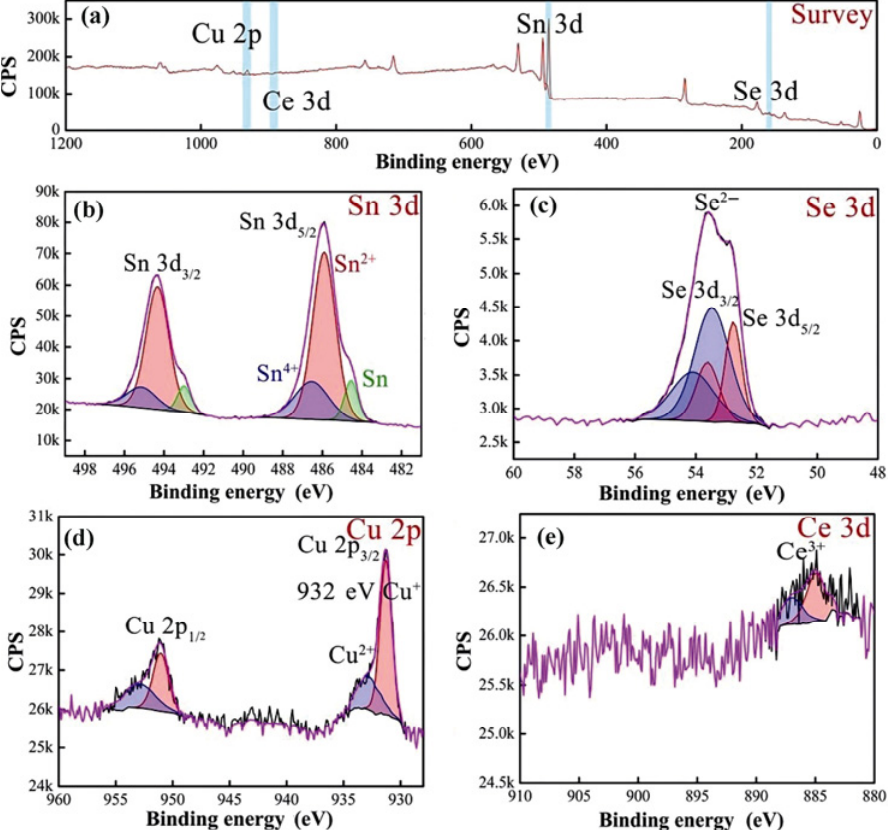
Fig. 6 (a) Survey scan of XPS spectrum for synthesized powders of Sn 0.98 Cu 0.01 Ce 0.01 Se. High-resolution scans of XPS spectra for (b) Sn 3d, (c) Se 3d, (d) Cu 2p, and (e) Ce